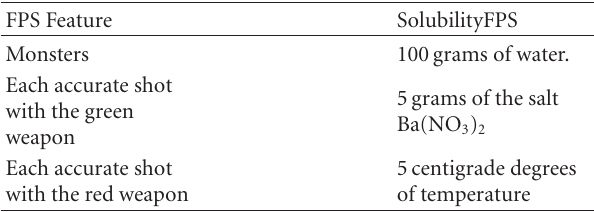
Figure 2: ChemLab FPS game—collecting Na 2 SO 4 at killing the white monster. Table 2: Metaphorical correspondences for SolubilityFPS.